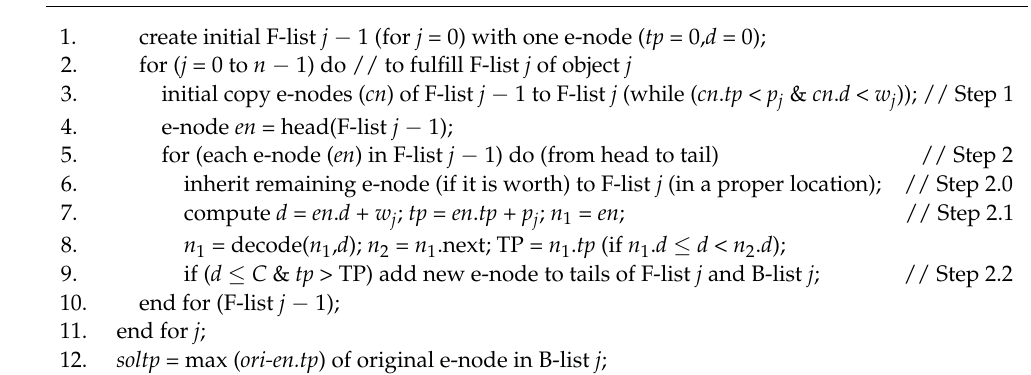
Algorithm 7: Preprocessing of the DPT-List TSR